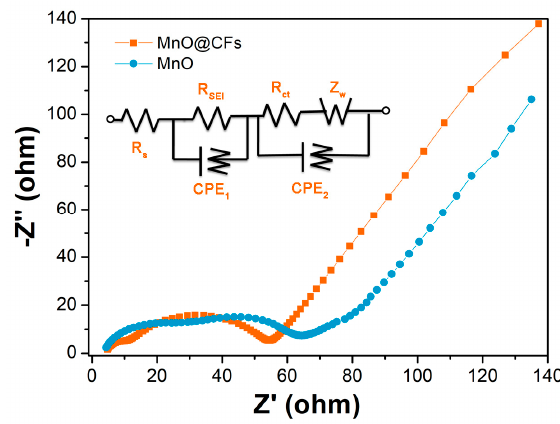
Figure 6. Nyquist plots for the MnO@CFs and MnO electrodes. Inset shows the equivalent circuit.